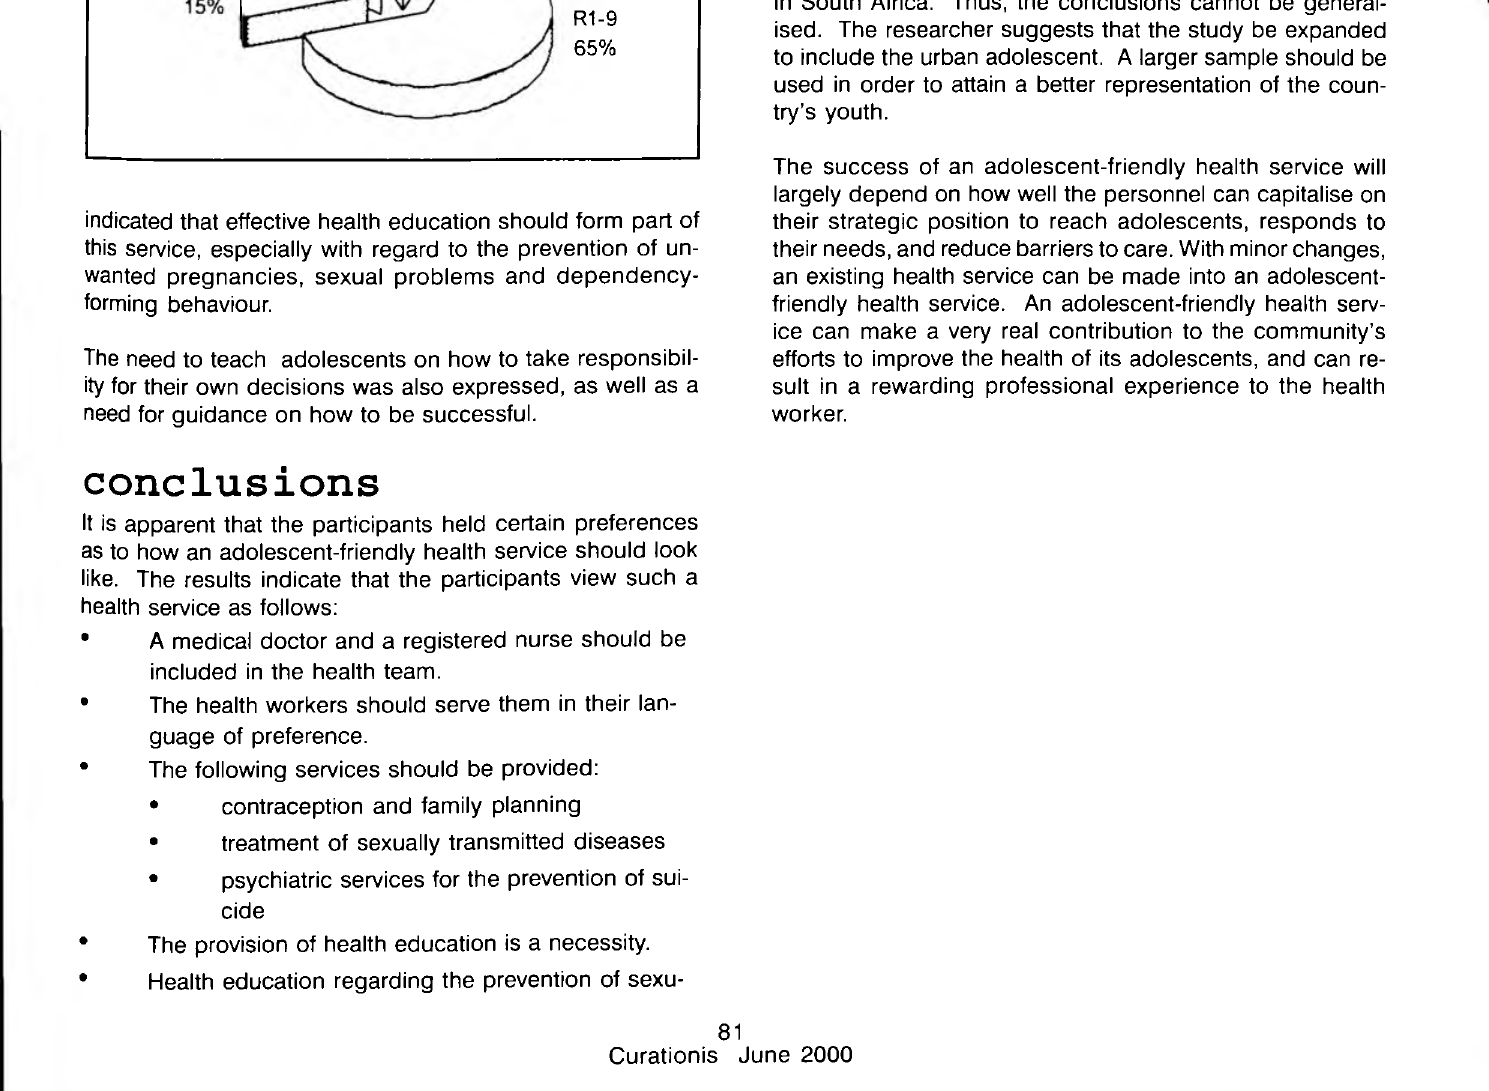
Figure 6 Am ount th a t p a rtic ip a n ts a re w illing to pay fo r a v is it to